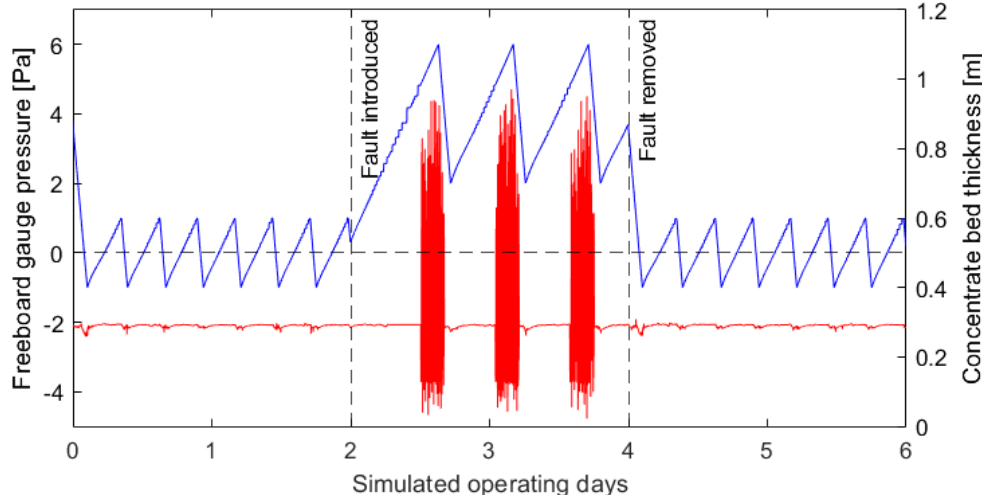
Figure 5. Illustration of how increasing the concentrate bed thickness (blue) causes PPEs, where the freeboard gauge pressure (red) becomes positive [20]. A PPE-causing fault is introduced at 2 days of simulated operation; during this time the bed thickness is maintained at levels where PPEs occur when the bed ruptures.